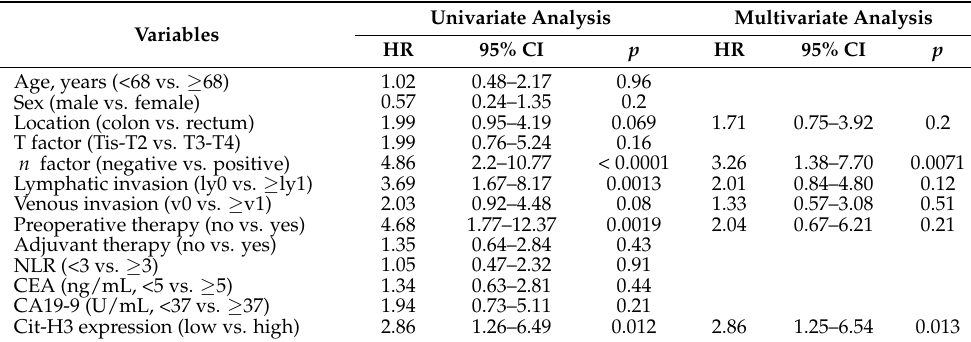
Table 1. Univariate and multivariate analysis using clinicopathological characteristics and Cit-H3 expression for RFS in 133 CRC